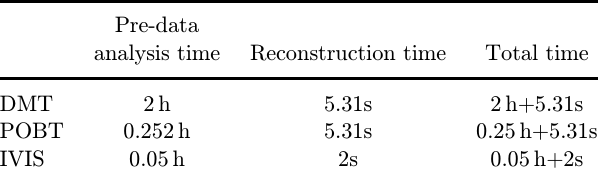
Fig. 6. Intensity pro¯les of IVIS, POBT and DMT techniques. (a) – (c) Transversal planes of the same xenograft with the tumor lesion indication reconstructed by IVIS, POBT and DMT techniques, respectively. (d) The normalized intensity pro¯les of the IVIS image (blue curve), the POBT image (red curve) and the DMT image (green curve) along the red dotted lines in (a) – (c). The x -axis in (d) denotes the actual distance in millimeters along these red dotted lines. Table 1. Reconstruction e±ciency of DMT, POBT and